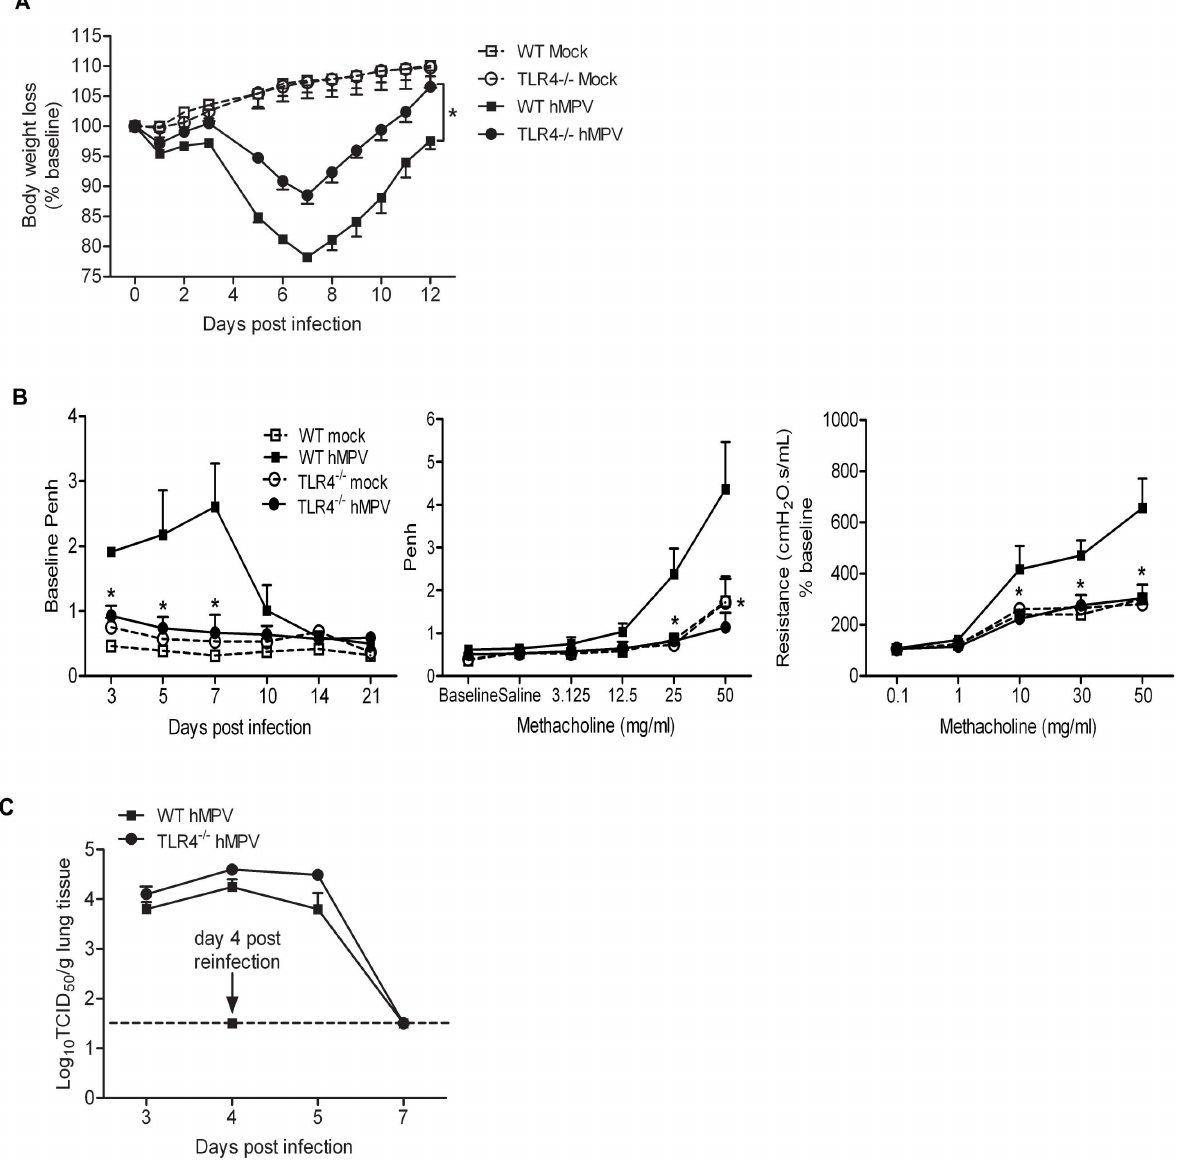
Figure 1. HMPV-induced clinical disease, lung function and viral replication in the absence of TLR4. TLR4 2 / 2 and wild type (WT) mice were either infected with hMPV (live or UV inactivated) or mock infected. Change in body weight was measured over a period of 12 days. Body weight is expressed as percentage of baseline weight ( A ). Baseline Penh values were measured over a period of 21 days; post-methacholine challenge airway hyperresponsiveness and airway resistance were measured at day 14 p.i. ( B ). TLR4 2 / 2 and WT mice were infected with hMPV and sacrificed at days 3, 4, 5 and 7 p.i. to determine viral titers by TCID 50 assay. Mice were challenged with hMPV (10 7 pfu) 6 weeks after primary infection and lung viral titers were determined on day 4 p.i. (peak of viral replication). The lower limit of detection of this assay is 1.5 log 10 /gram of tissue, represented by the dotted line ( C ). Data are expressed as mean 6 SEM of four to six animals/group. Figure 1A and B represents one of three independent experiments and Figure 1C represents cumulative data from three independent experiments. * P , 0.05 when comparing hMPV infected TLR4 2 / 2 mice to WT